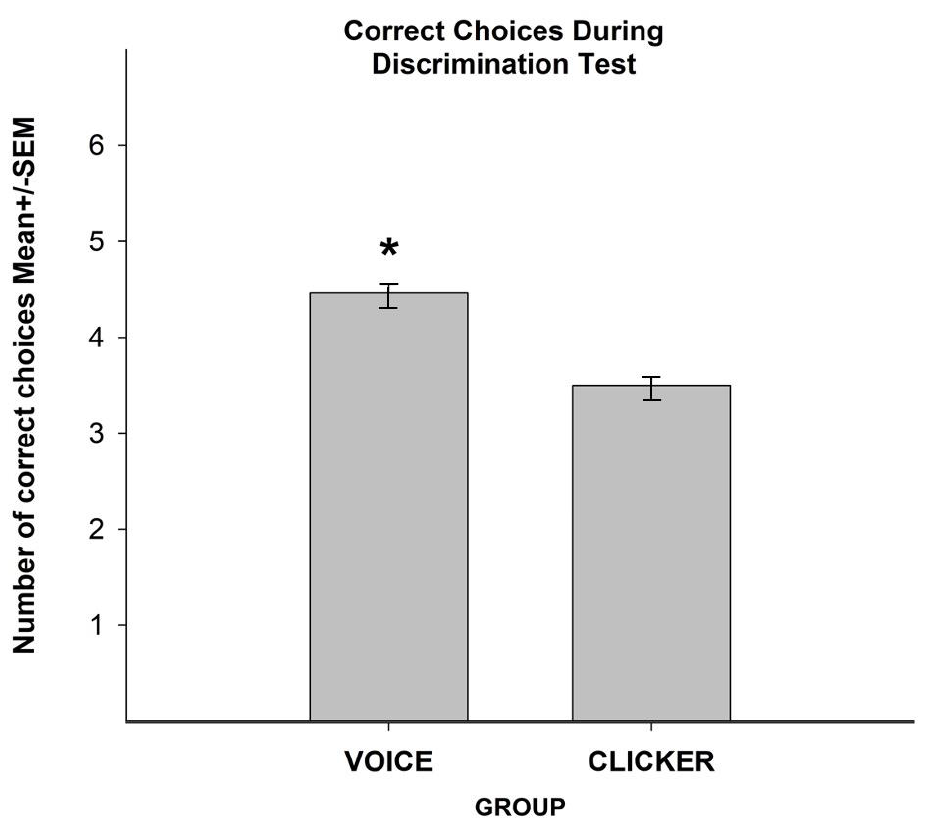
Figure 5. Piglets trained with voice displayed more correct choices during object discrimination trials compared with those trained with a clicker. * indicates p < 0.05.